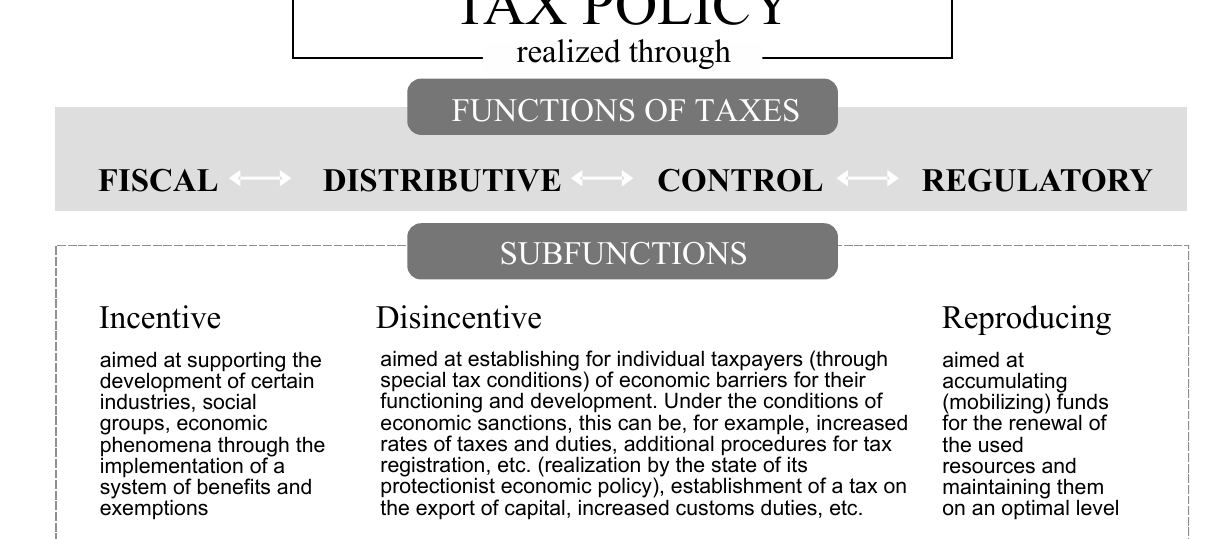
Figure 2. The functions of taxes through which an effective tax policy is realized